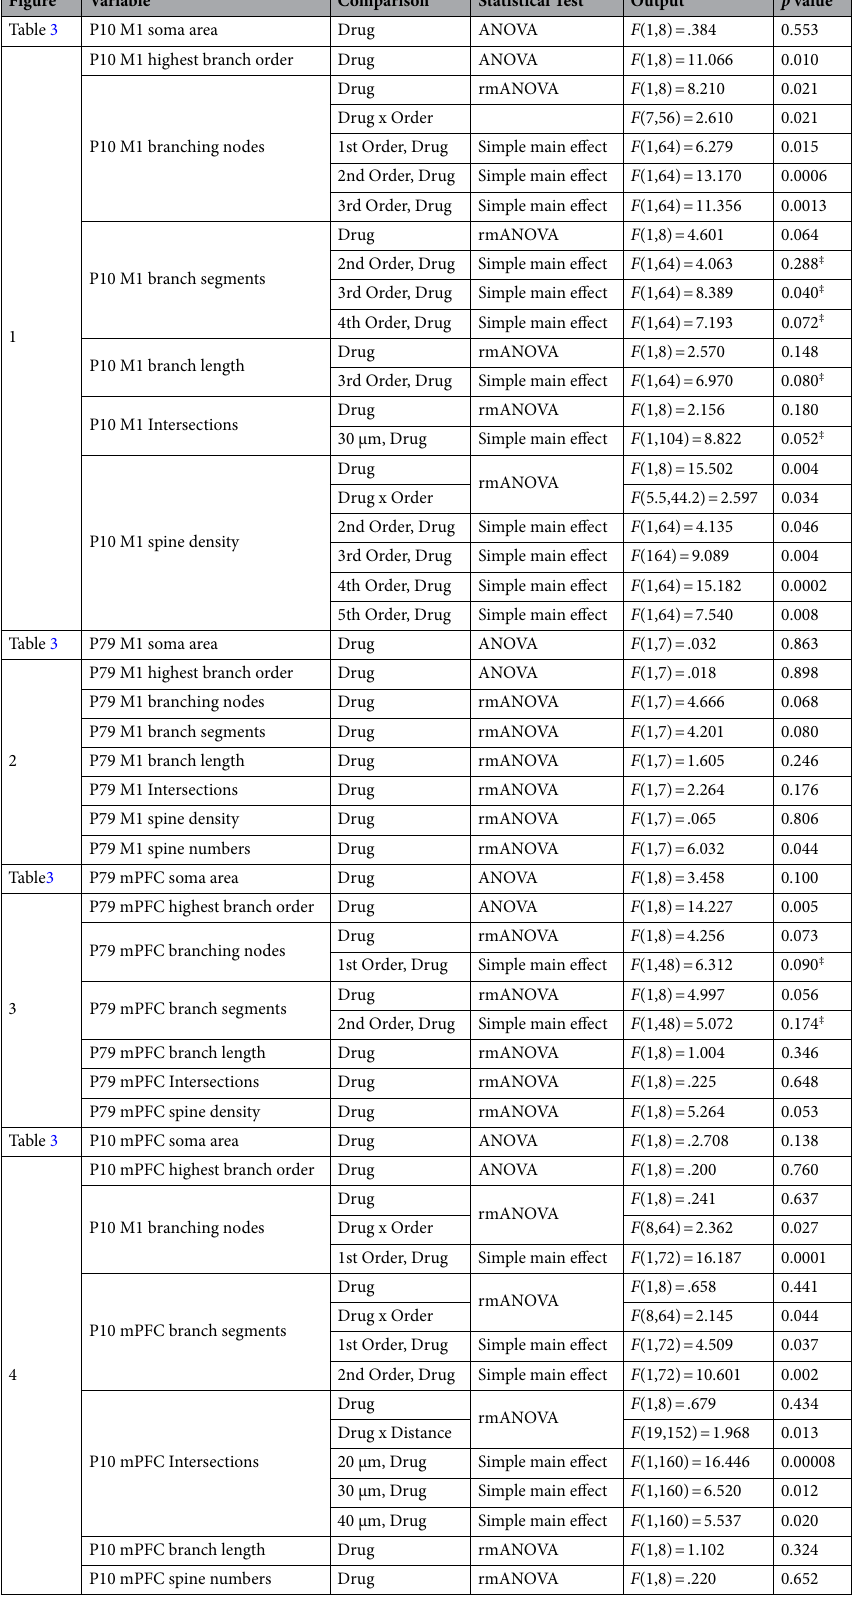
Table 2. Statistical analysis results from all experiments. ‡ Indicates Bonferroni corrected observed p